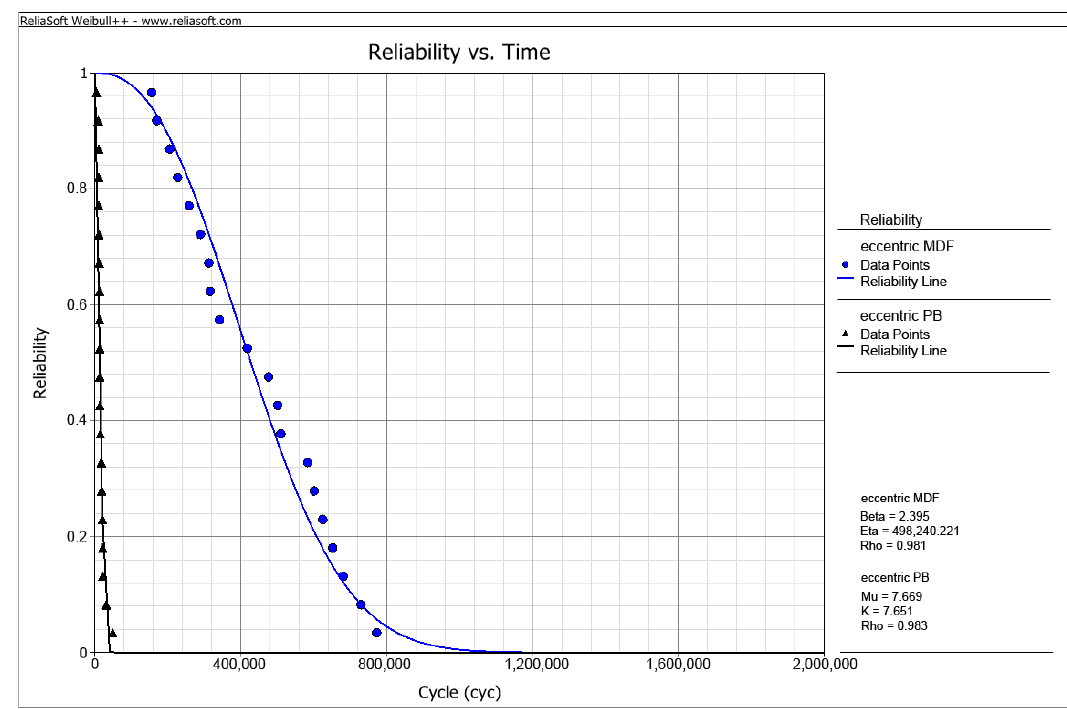
Figure 2. The comparison of the reliability of case-type furniture eccentric joints made of MDF and particleboard of 18 mm.